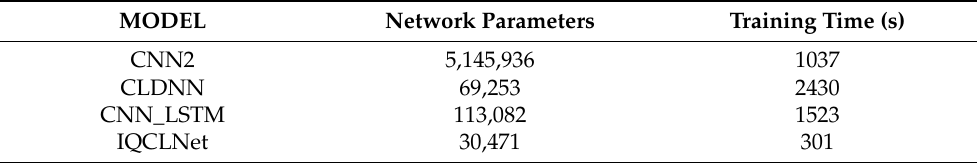
Table 4. Parameters and computer time of different